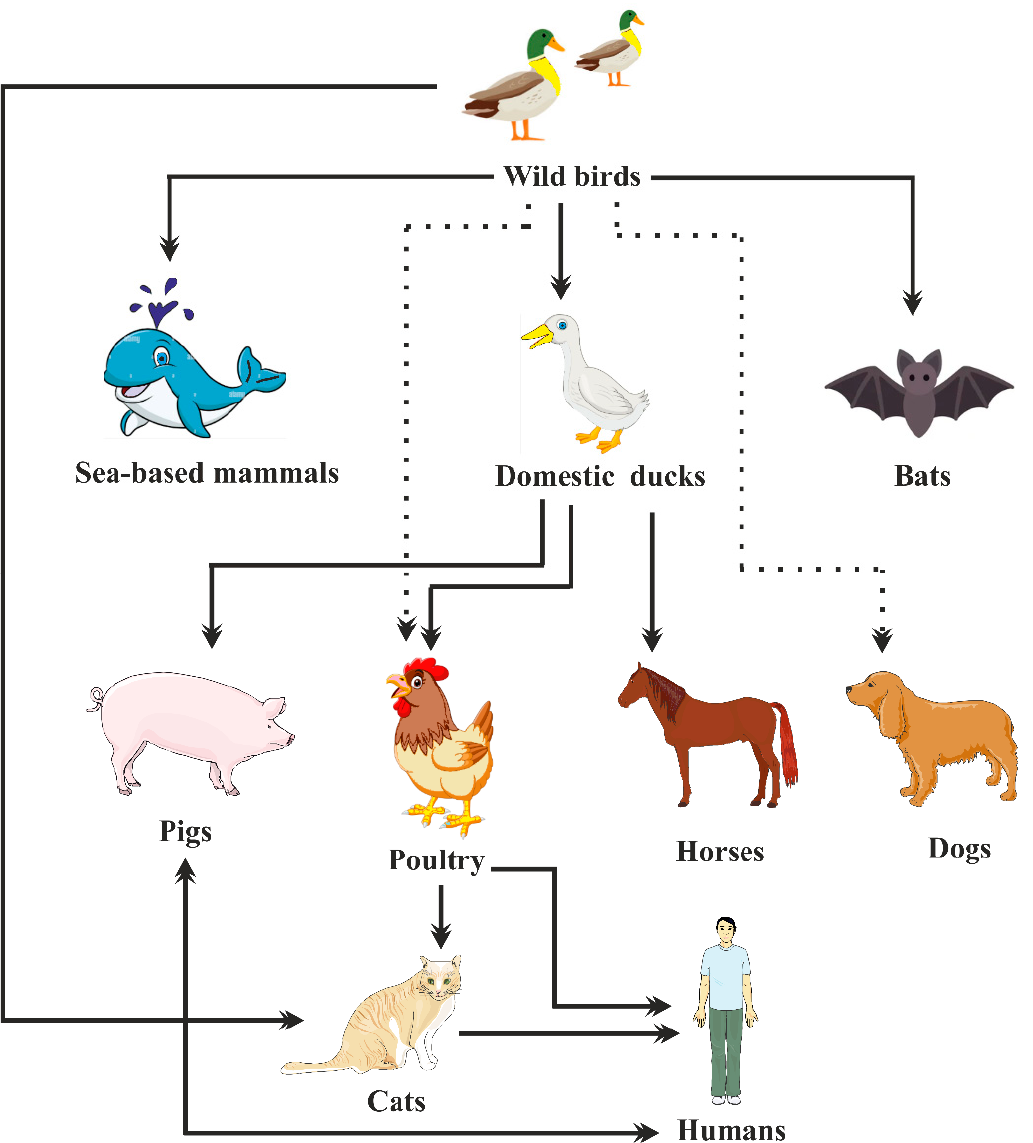
Figure 5. Emergence of influenza A virus from reservoirs of wild aquatic birds. Wild bird influenza viruses can spread to marine animals and domestic free-range ducks via water or fomites. Trans- missions to other avian species (such as poultry) can result from contaminated water, domestic ducks or directly from wild birds. Dogs and cats are other household animals that are susceptible to influenza virus infections. Influenza virus can also be transmitted from poultry to humans, who can also acquire it from cats. Transmission that avoids a domestic duck intermediary is represented by dashed lines.